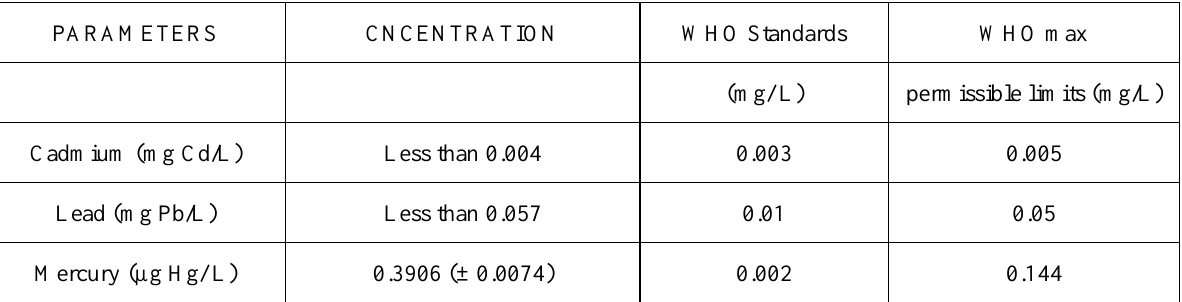
Table 1. Concentration of heavy metals in water from Kawasan